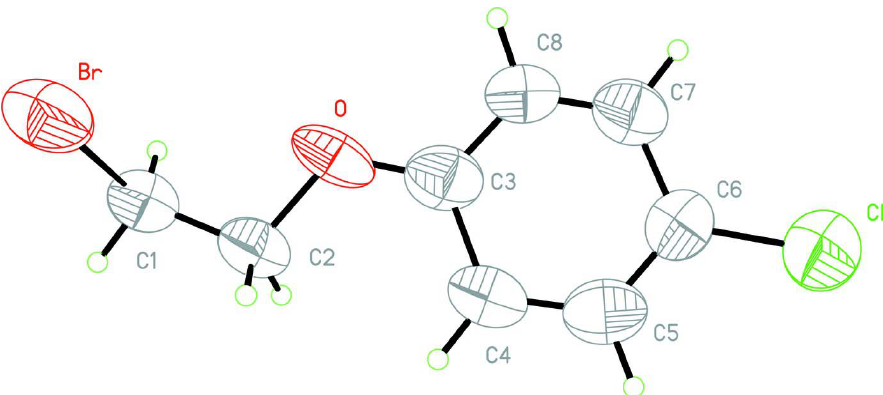
Figure 1 The molecular structure of the title molecule, with the atom-numbering scheme. Displacement ellipsoids are drawn at the 30% probability